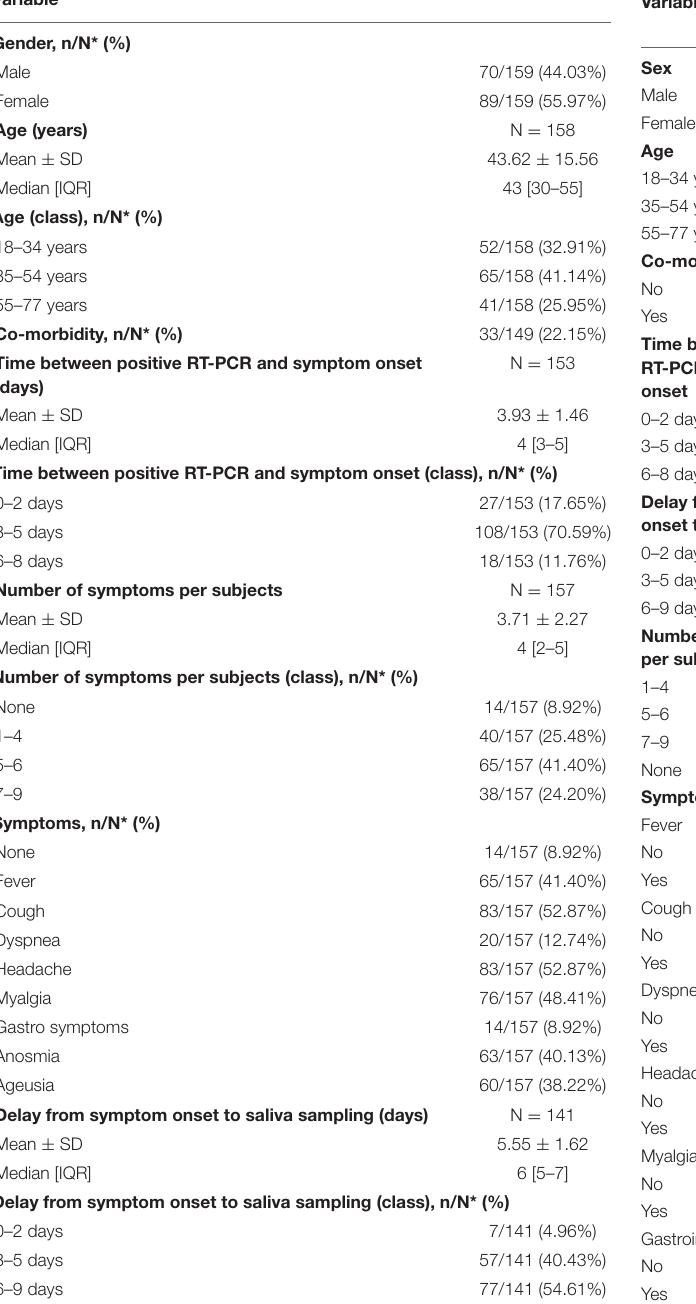
TABLE 2 | Baseline characteristics of enrolled patients with Coronavirus Disease 2019. Variable